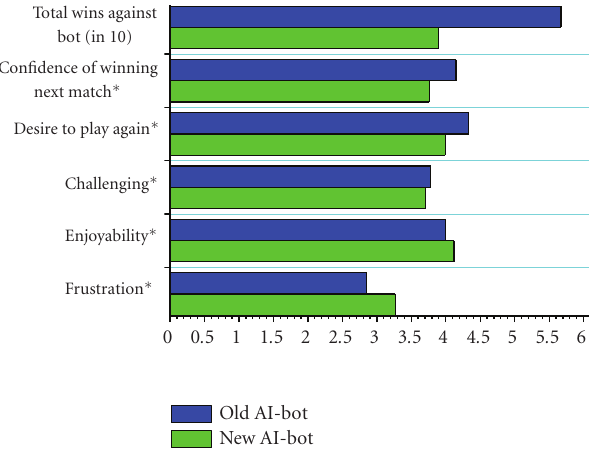
Figure 12: Results of the conducted survey, averaged over 10 games. Values marked with an asterix range from 1 = very low to 6 = very high.